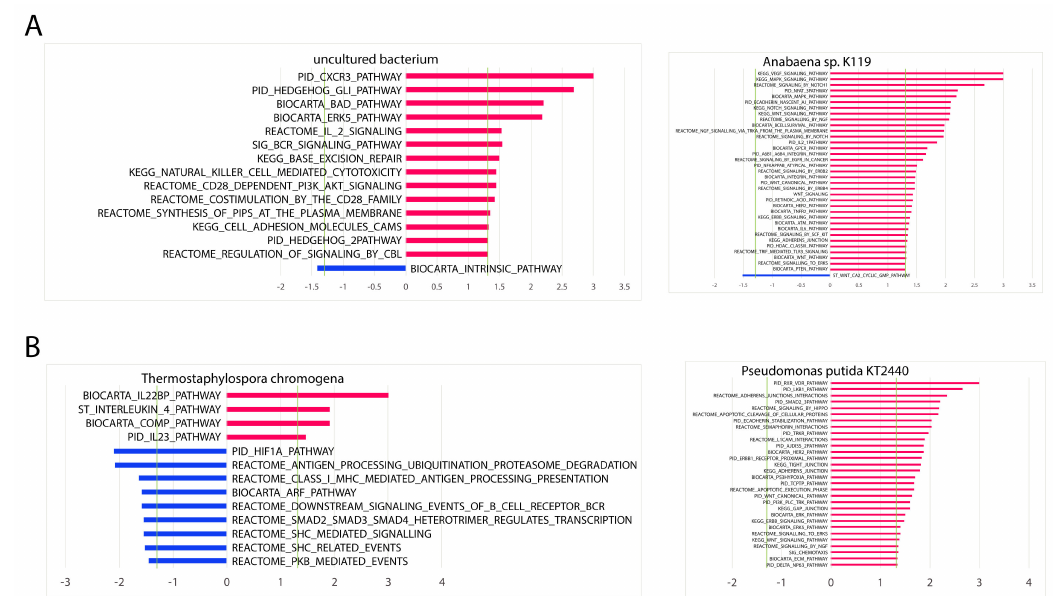
Figure 7. Association between di ff erentially abundant microbes in LUAD and LUSC to cancer and immune pathways. Bar plot of the log( p -value) for positive associations and -log( p -value) for negative associations for significant cancer and immune pathways (GSEA, p < 0.05) in ( A ) LUAD and ( B ) LUSC. Green vertical lines indicate the significance cut-o ff of log(0.05) and − log(0.05), where values falling outside of the region bordered by the green lines indicate significance. Only the two most di ff erentially abundant microbes in each cancer are included (Kruskal–Wallis test, p <